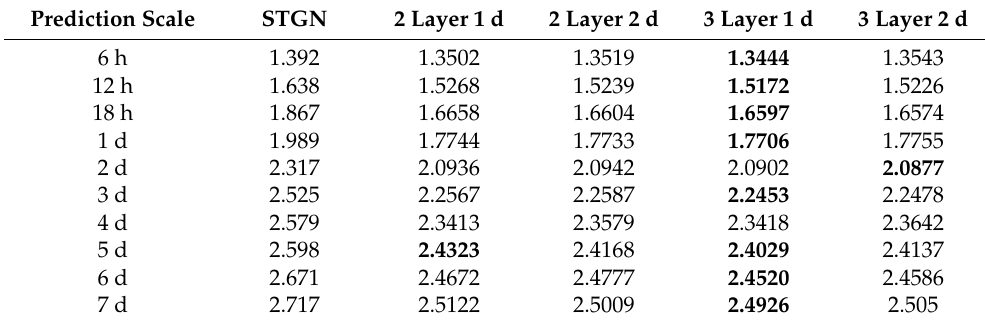
Table 6. RMSE of forecasting methods of different K and dilation factor d for 40 nodes. Prediction